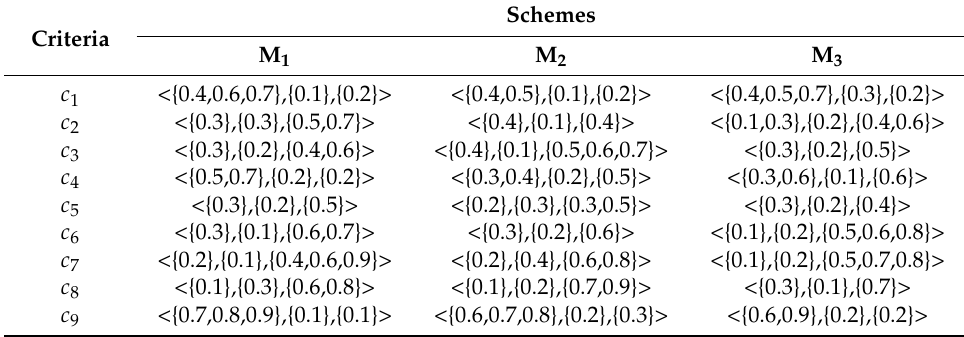
Table 1. The evaluations of three schemes by decision-makers under